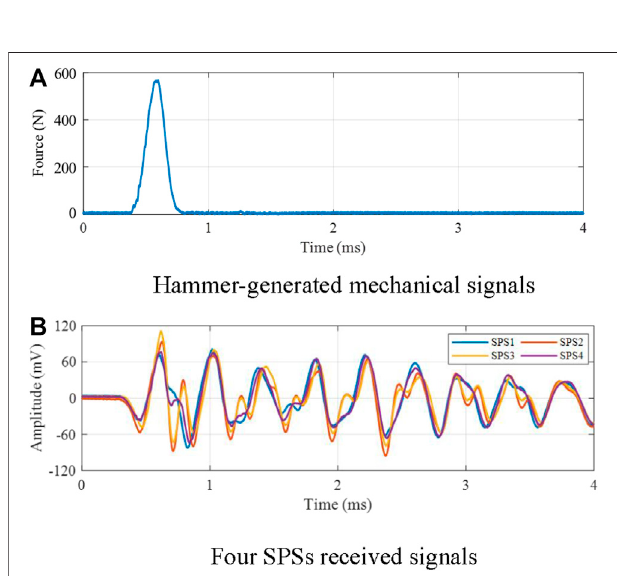
FIGURE 11 | Hammer-generated mechanical signals and SPS-received signals. (A) Hammer-generated mechanical signals. (B) Four SPS-received